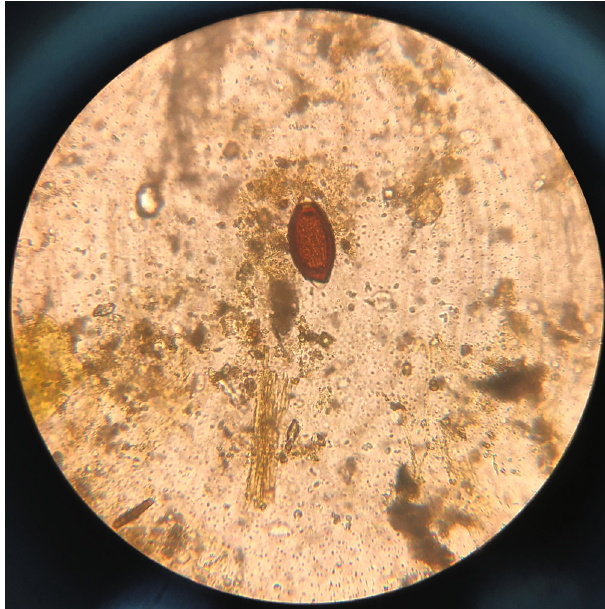
Figure 6: Trichuris : egg of parasite. Barrel-shaped eggs, 70 – 90 μ m in length, with bipolar plugs, granulation of the content.